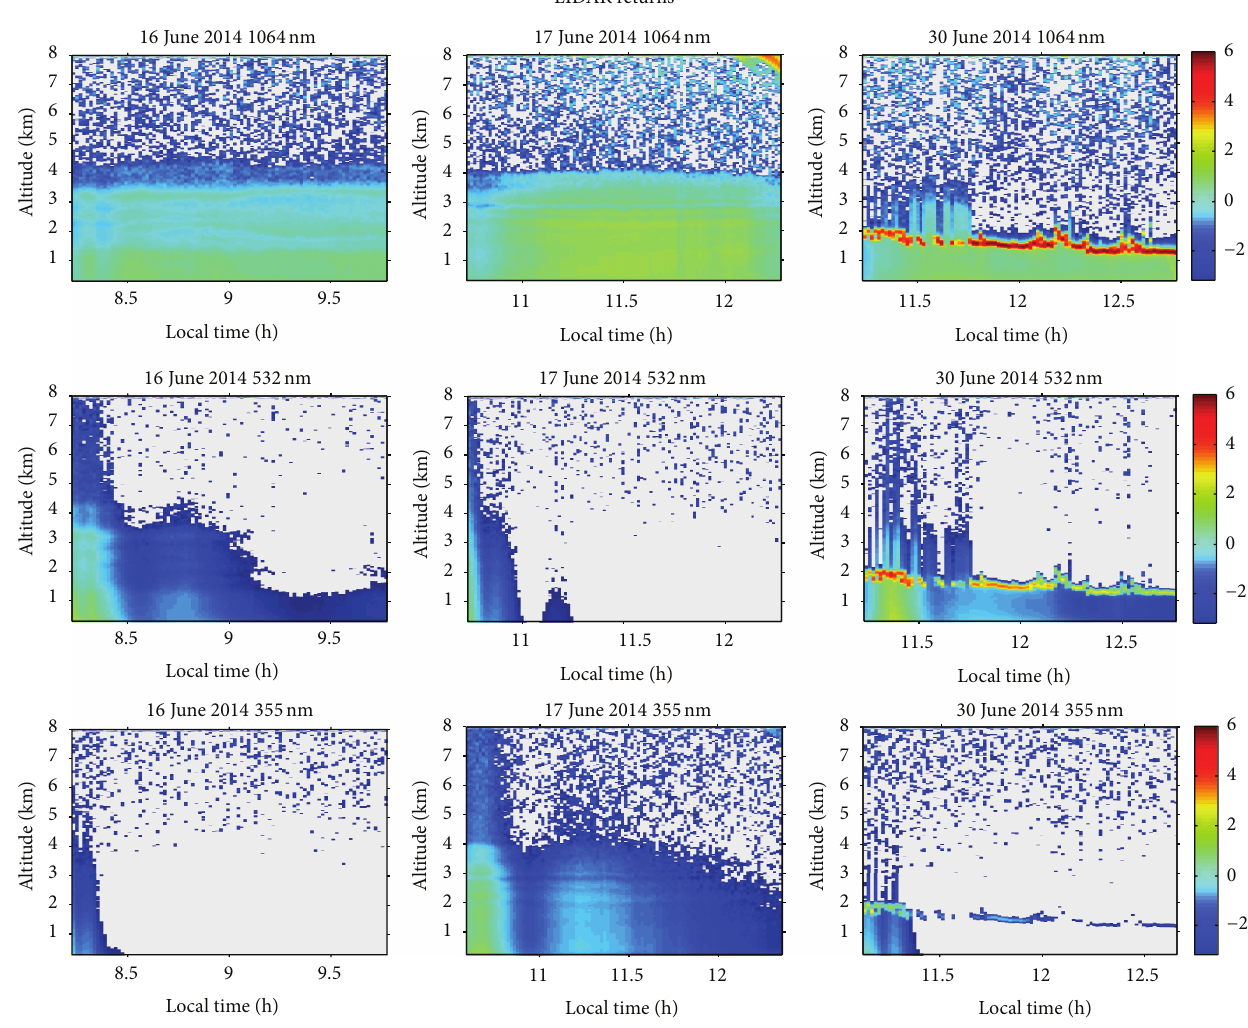
Figure 6: LIDAR returns. Color scale represents signal